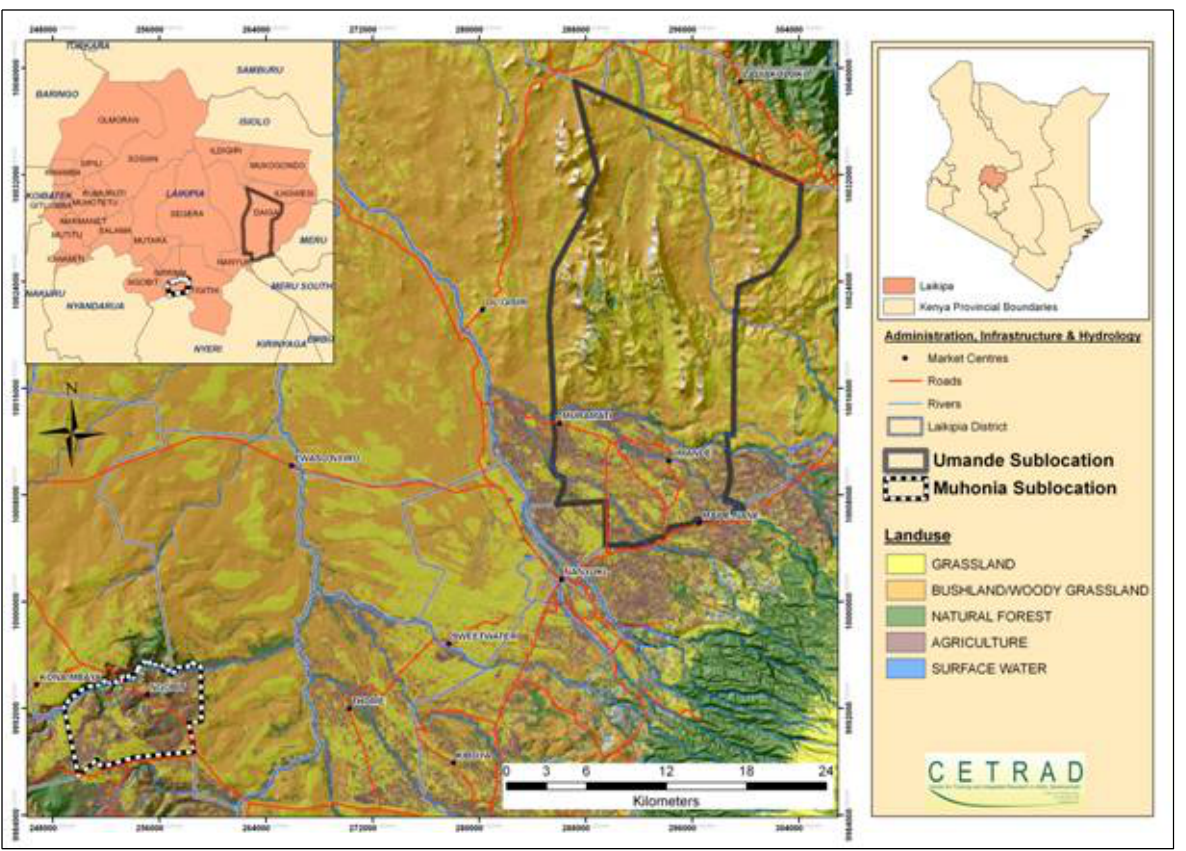
Figure 1. Map Showing the Sublocations of Umande and Muhonia in Laikipia,